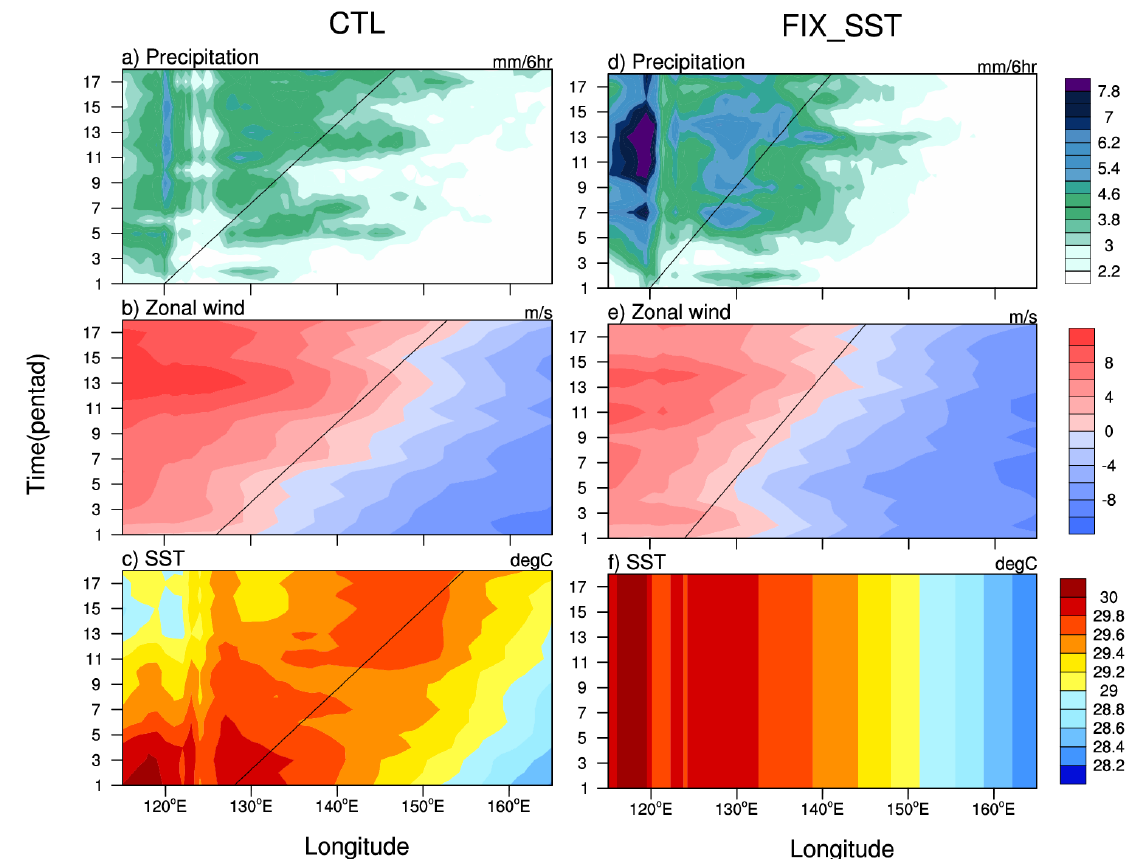
Figure 5. Hovmoller diagrams of climatological pentad - mean ( a ) precipitation ( unit: mm/6 h) , ( b ) zonal wind (unit: ms − 1 ) at 850 hPa, and ( c ) SST (unit: ◦ C) for the control experiments (CTL, left panel) . ( d – f ) ( right panel): Same as in ( a – c ) except for the Sensitivity experiments ( FIX_SST). The averaged latitude strip for both CTL and FIX_SST is from 12° N to 17° N .